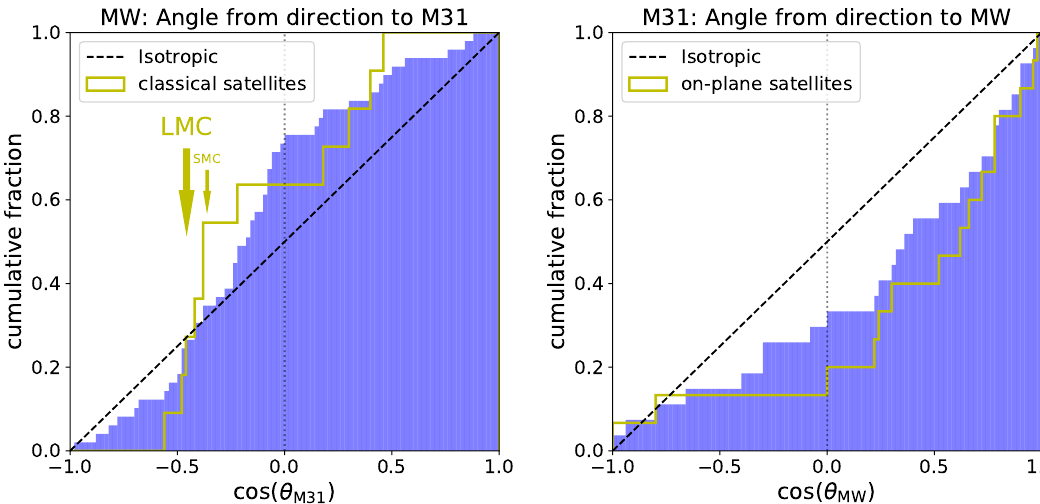
Figure 8. Cumulative distribution of the cosine of the angle θ between the position of satellites around the MW ( left-hand panel ) and M31 ( right-hand panel ), and, respectively, the direction from the MW to M31, and from M31 to the MW. The dashed black line indicates the expectation for an isotropic distribution. The dotted vertical line separates the hemispheres facing away from ( left half , cos ( θ ) < 0) or towards ( right half , cos ( θ ) > 0) the other major galaxy. The yellow lines give the cumulative distribution for only the 11 classical satellites of the MW, and for only the on-plane satellites of M31, respectively. For M31, there is a clear lopsidedness towards the MW, which is even more pronounced for the satellites that are members of its satellite plane. The MW satellites tend to preferentially face away from M31 (i.e., globally in the same direction as the M31 satellites), but uneven survey coverage areas and the presence of the LMC (corresponding angle indicated with a yellow arrow) with an entourage of its own satellites make this difficult to